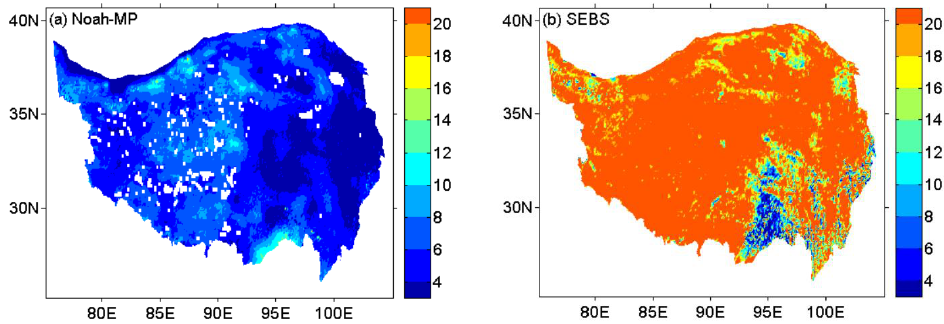
Figure 4. Standard deviation (STD) of annual mean SH fluxes (Wm − 2 ) simulated by ( a ) Noah-MP and ( b ) SEBS on the TP during the period 2001 – 2018.